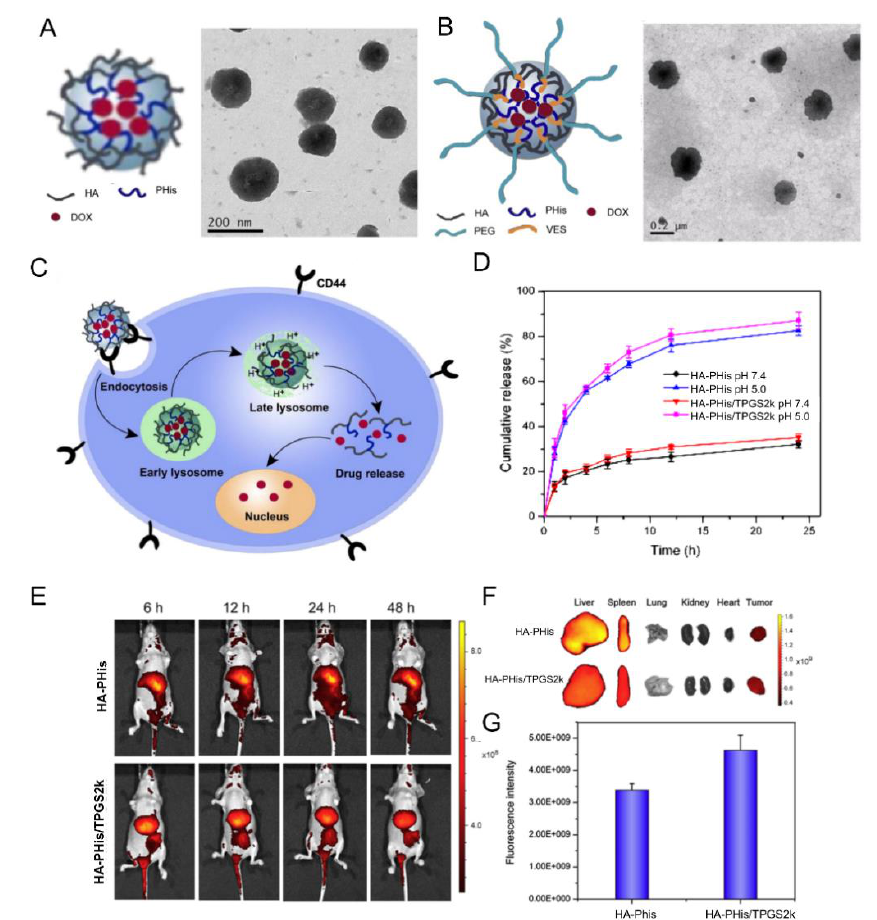
Figure 5. Schematic illustrations of self-assembly and TEM image of HA-PHis nanogels ( A ) HA-PHis / TPGS-2k ( B ). ( C ) pH-sensitive release profile of DOX from HA-PHis in PBS (pH 7.4 and 5.0) at 37 ◦ C. Data as mean values ± SD ( n = 3). ( D ) pH-sensitive release profile of DOX from HA-PHis and HA-PHis / TPGS2k in phosphate bu ff ered saline (PBS) (pH 7.4 and 5.0) at 37 ◦ C. Data as mean values ± SD ( n = 3). ( E ) In vivo imaging of tumor-bearing mice administrated with DIR-loaded micelles. Images taken after administration of HA-PHis at 4 h and 12 h, and HA-PHis / TPGS2k for 4 h and 12 h, respectively. ( F ) Ex vivo fluorescence images of tumors and organs collected at 12 h post-injection of HA-PHis / TPGS2k and HA-PHis micelles. ( G ) Quantification of the ex vivo tumor uptake characteristics of micelles. Uptake expressed as fluorescence per mm 2 of tumor. Data as mean values ± SD ( n = 3). Adapted with permission from [57,58]. Copyright 2019, Elsevier.